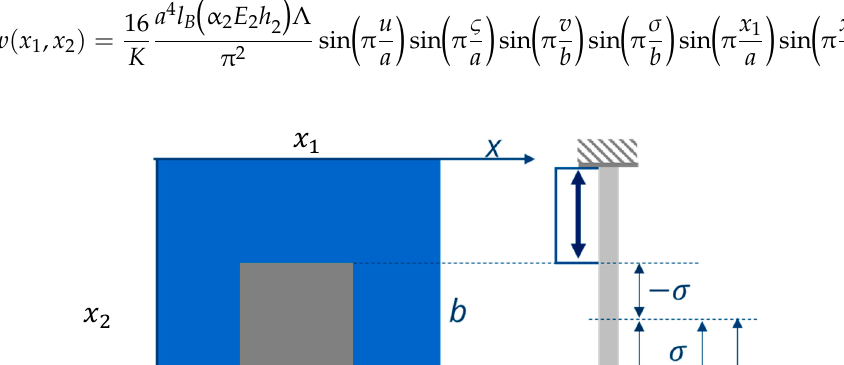
Table 3. Material and geometrical parameters of a silicon bending plate covered with hydrogel [7,25]. Parameter Silicon plate Hydrogel layer Length (cid:1853) [mm] 4 variable variable 131000 500 at 90%R.H.